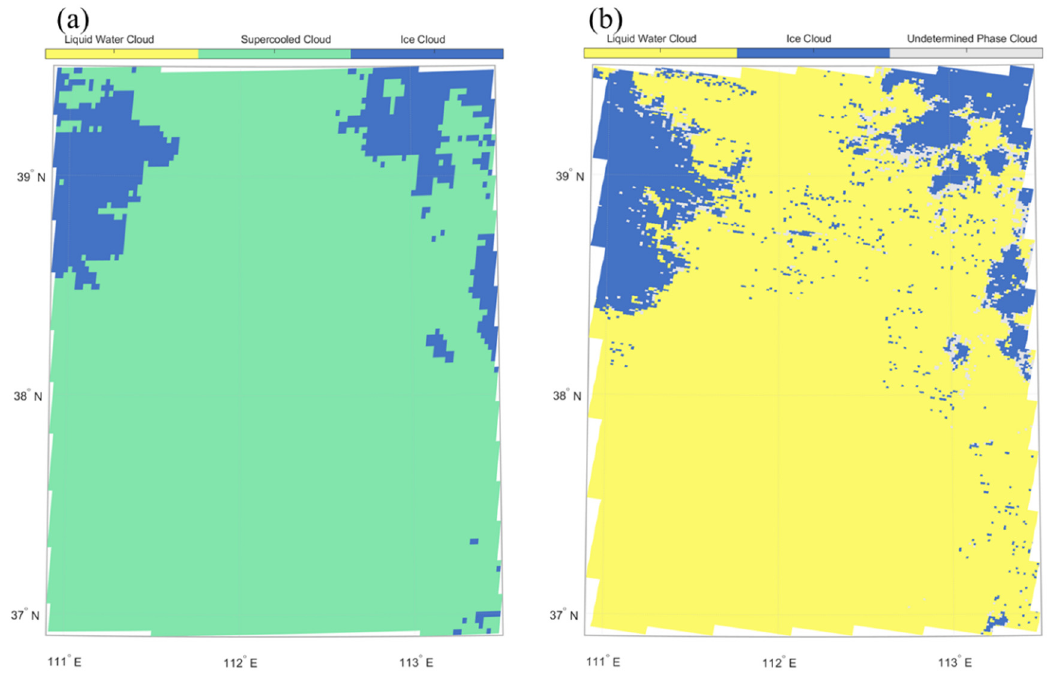
Figure 10. FY-4A cloud phase based on RGB composition at 03:15 UTC ( a ) and cloud phase products at 03:10 UTC from MODIS ( b ) on 29 November 2019.